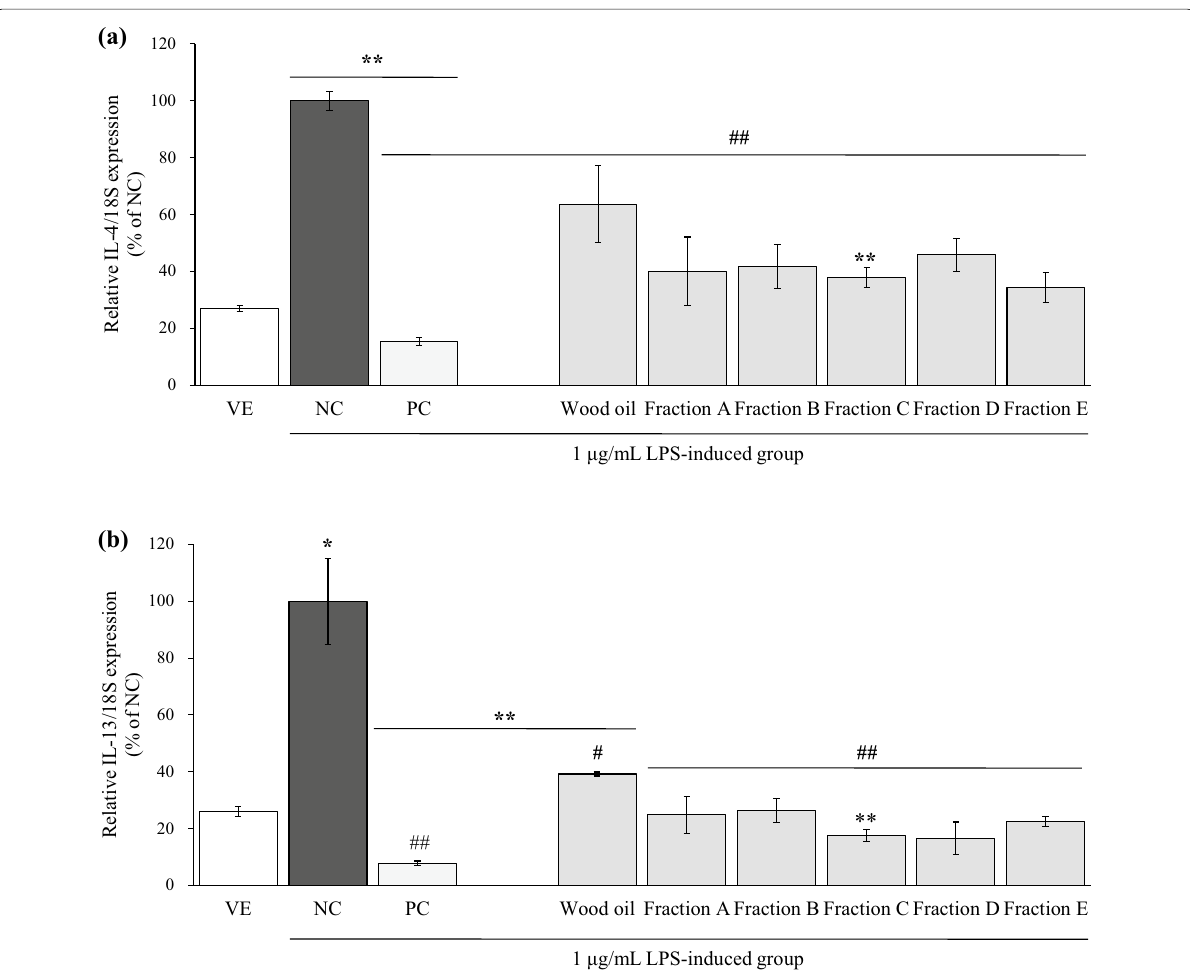
Fig. 4 Effects of the wood essential oil and five oil fractions on a IL‑4 and b IL‑13 mRNA expression levels. VE: vehicle, DMSO; NC: negative control, 1 μg/mL LPS‑treated group; PC: positive control, 100 nM dexamethasone treated group, an oil fraction (A–F) (0.08 μg/mL). Values are presented as mean standard deviation. * p < 0.05 and ** p < 0.01 compared with VE; and # p < 0.05, ## p < 0.01 compared with ±